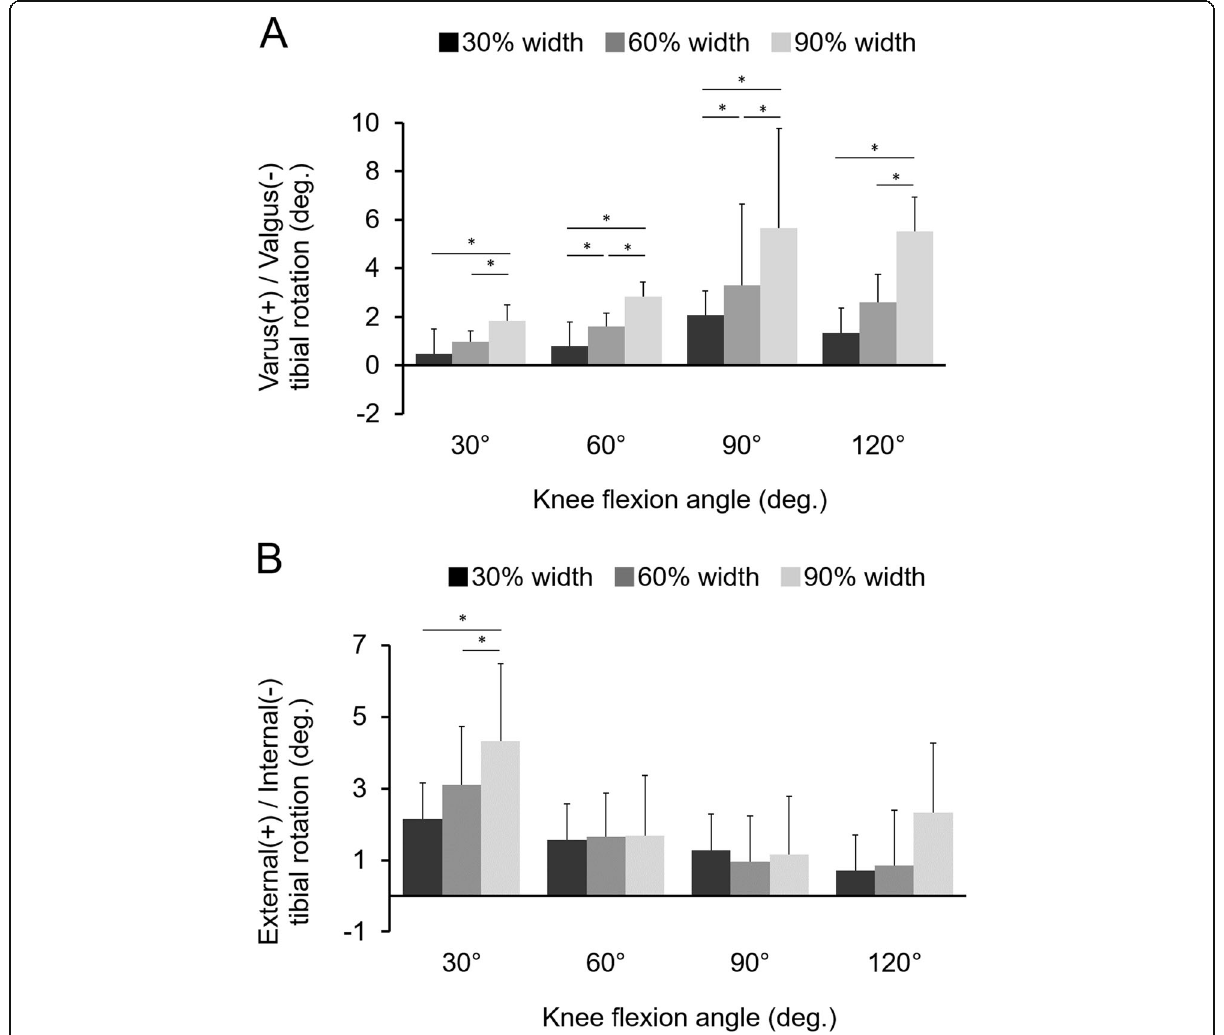
Fig. 6 Tibiofemoral relationship under an axial load of 300 N against an intact knee. ( a ) Varus/valgus rotation ( b ) Internal/external rotation *: significant difference ( p <